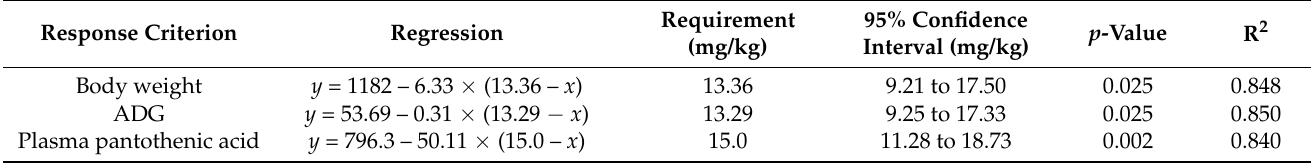
Table 6. Pantothenic acid requirements of male white Pekin ducks from hatch to 21 days of age based on broken-line regression analysis. Response